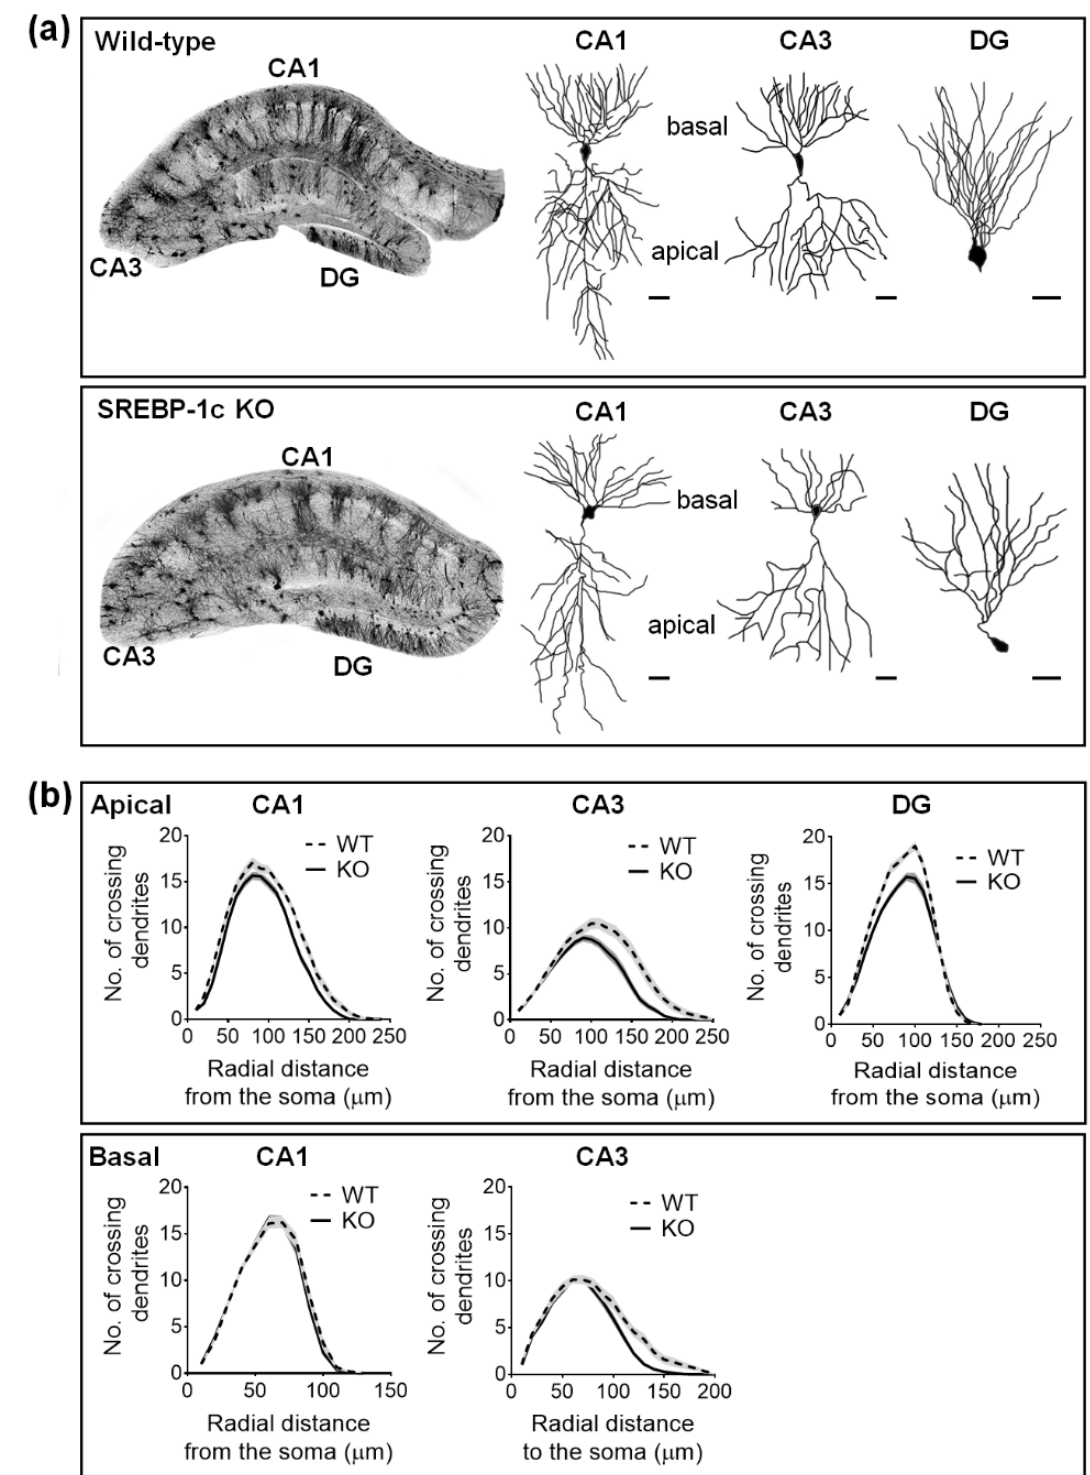
Figure 2. SREBP-1c KO mice display impaired dendritic complexity in the CA1, CA3, and DG subregions of the hippocam- pus. The figures show the representative images of the Golgi-stained hippocampus and subregional neurons in WT and SREBP-1c KO mice ( a ). The line graphs show the mean number of intersections per 10 µ m radial unit distance from the soma (0) for apical (( b ); upper) and basal (( b ); lower) dendrites. Data are expressed as means ± standard errors (SEs) of 10 neurons of each subregion in each mouse ( n = 40 dendrites/group). The scale bars in ( a ) represent 25 µ m. CA, cornu ammonis ; DG, dentate gyrus; WT, wild-type littermate; KO, SREBP-1c KO